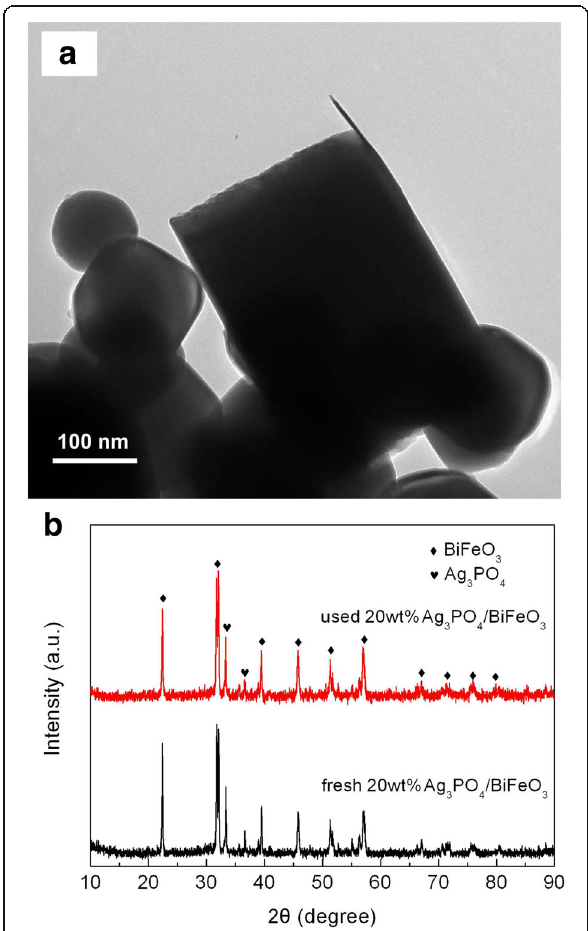
Fig. 8 a TEM image and b XRD pattern of 20wt%Ag 3 PO 4 /BiFeO 3 sample after cycling photocatalytic